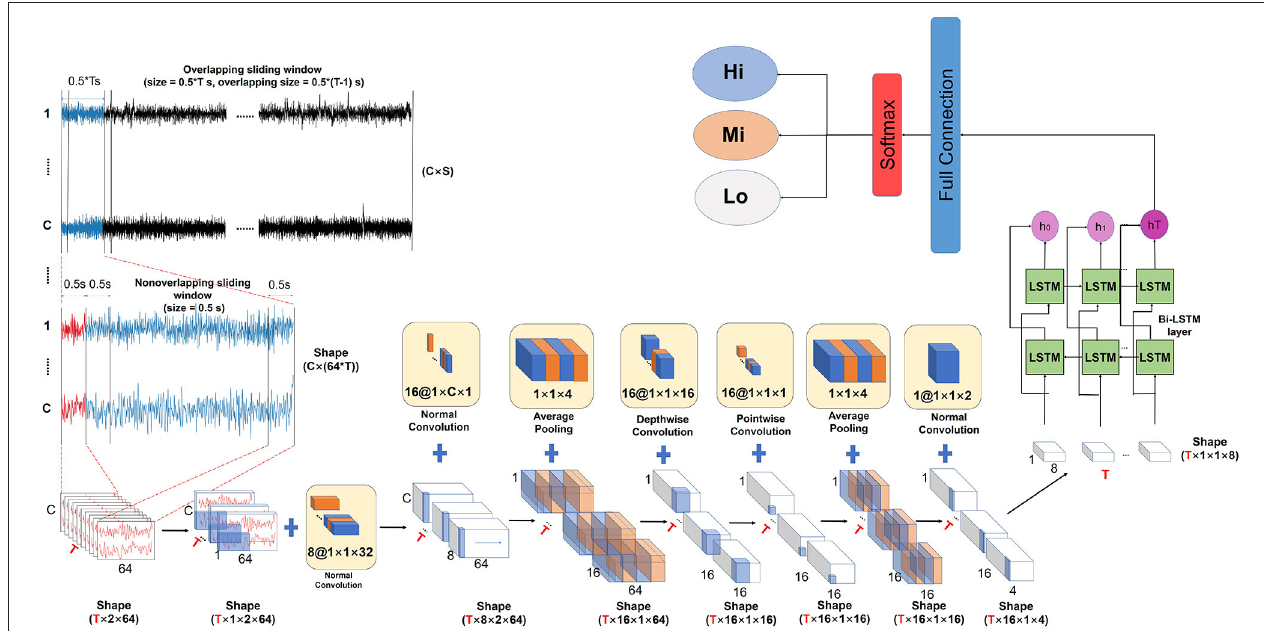
FIGURE 2 | The framework of the EEG-TNet model. The EEG-TNet model consists of Data segmentation, dimension expansion, time fixed 3-D-CNN layers, Bi-LSTM layer, fully connected layers, and softmax